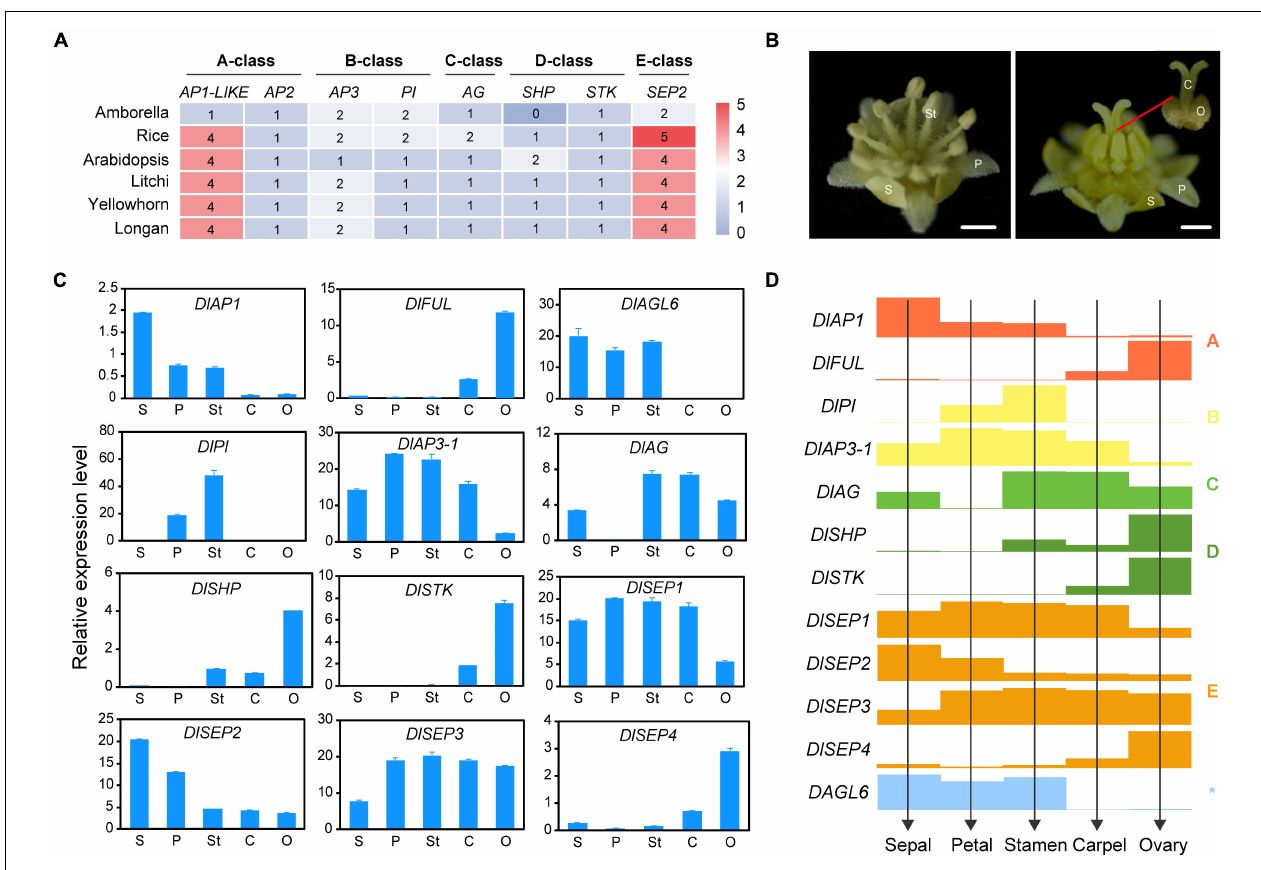
FIGURE 6 | The deduced ABCDE model in longan. (A) The heat map shows the number of ABCDE classes genes in Amborella, Arabidopsis, rice, and longan. (B) Mature male (left) and female (right) flowers of longan. Five types of floral organs including sepal (S), petal (P), stamen (St), carpel (C), ovary (O) were collected for gene expression analysis. (C) Expression analysis of ABCDE classes genes in floral organs in (B) by using qRT-PCR. (D) The ABCDE model in longan is proposed based on the gene expression levels (bar heights) from (C)